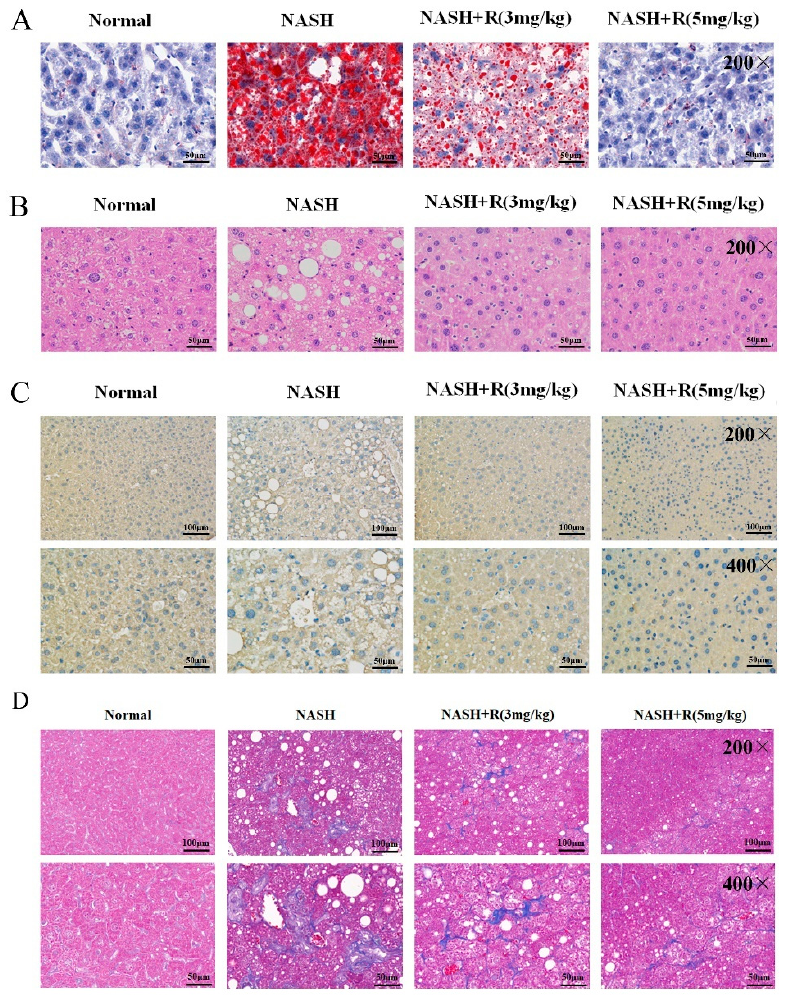
Figure 6. Resmetirom effectively inhibited lipid accumulation in NASH mouse model. ( A ), Sections of livers from mice in Figure 5 were used to perform the Oil red O staining assay to determine the lipid accumulation in liver tissue. ( B ), HE staining assay was used to confirm the pathological change in livers. ( C ), TUNEL assays were used to evaluate the cell apoptosis in liver tissues. ( D ), Masson stain- ing assays were used to evaluate the fibrosis status in liver tissues. For all experiments, representative pictures are